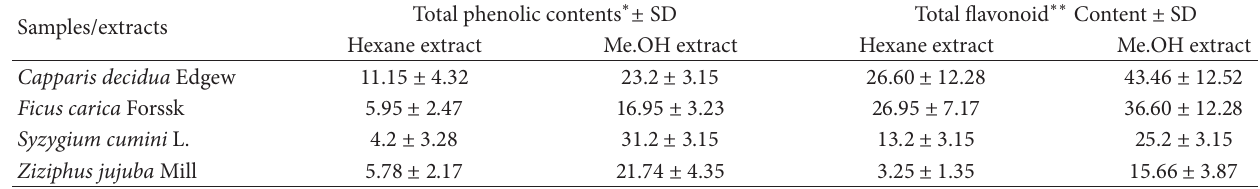
Table 3: The phytochemical constituents (flavonoid extract and total phenolic content) of selected plants form the studied area.